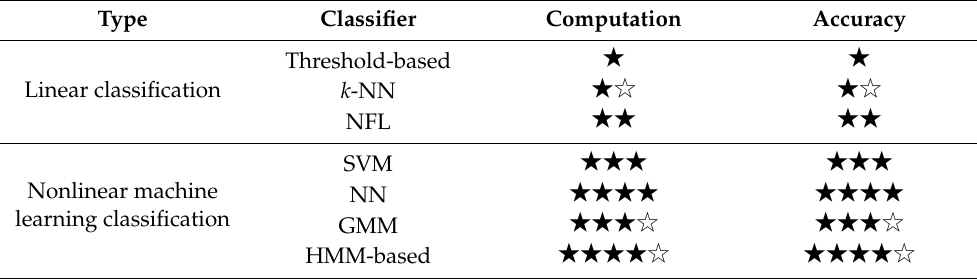
Table 2. Acoustic classification